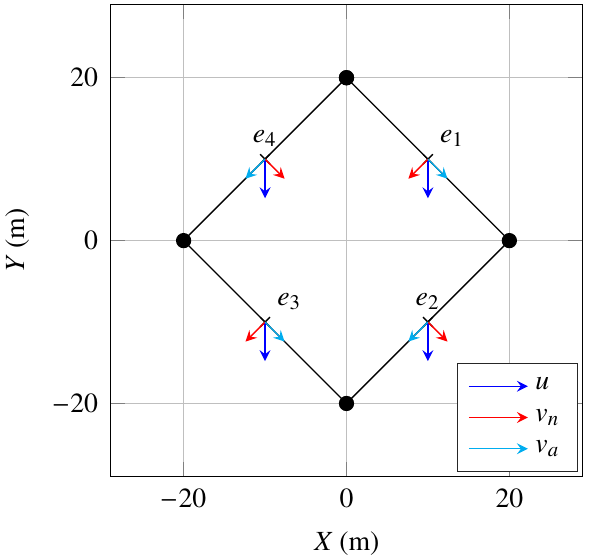
Figure 7. Diamond geometry used to validate the skewed turbulence generation algorithm. The flow is simulated in the middle of elements 1 to 4 with a northern wind direction. For each structural element e i ( i = 1,2,3,4), the axial and normal velocity components are denoted v a and v n , respectively. In Figure 7, the axes X and Y correspond to the longitude and latitude of the vertices, such that the ( X , Y ) plane is horizontal. The line joining e 1 and e 2 is aligned with the wind direction. Therefore, the along-wind and cross-wind distance between e 2 and e 1 are d x = 20 m and d y = 0 m, respectively. On the other hand, the line joining e 1 and e 4 is perpendicular to the flow, such that d x = 0 m and d y = 20 m. Finally, the line joining e 1 and e 3 combines both cross-wind and along-wind separations, with d x = 20 m and d y = 20 m. Figure 8 displays the time series of the u velocity component on e 1 and e 2 . The normalized cross-correlation function R u ( e 1 , e 2 ) in the bottom panel of Figure 8 reaches its maximum near 0.80 s, which correspond to the advection time between e 1 and e 2 . The largest value of R u ( e 1 , e 2 ) is below 1, which underlines the loss of correlation in the along-wind direction due to the along-wind root-coherence introduced to relax Taylor’s hypothesis of frozen